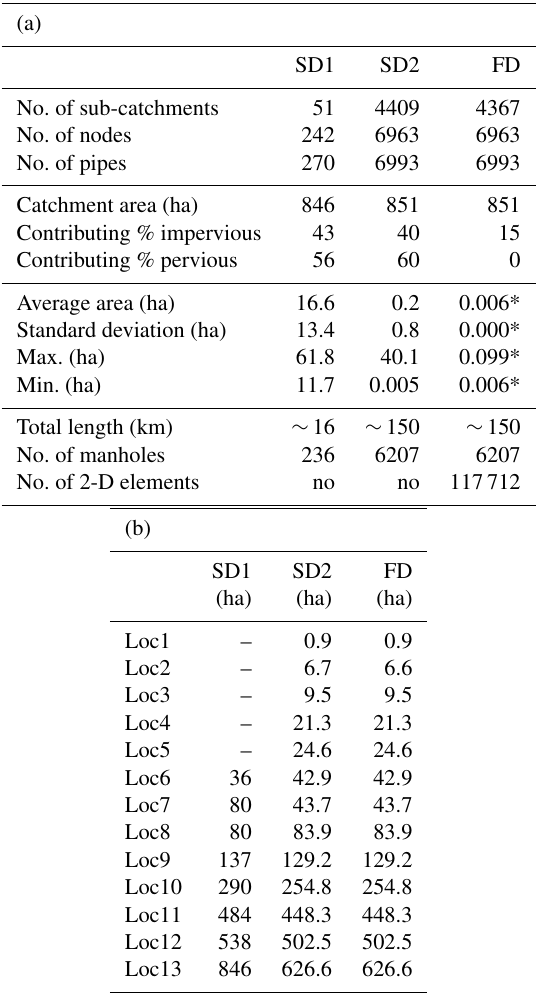
Table 2. (a) Summary of the hydrological model characteristics of the three models. (b) Drainage area connected to the investigated locations for each